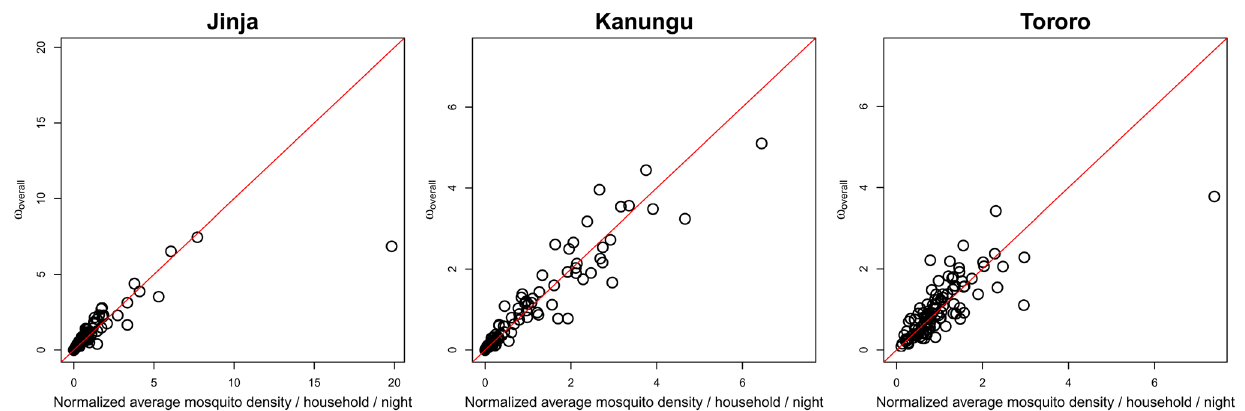
Figure 2. Household biting propensities for the entire duration of surveillance ( ω mosquito density per household per night for each of the study sites. The red line denotes the 1:1 line. Evidently, ω relationship with mosquito density at each study